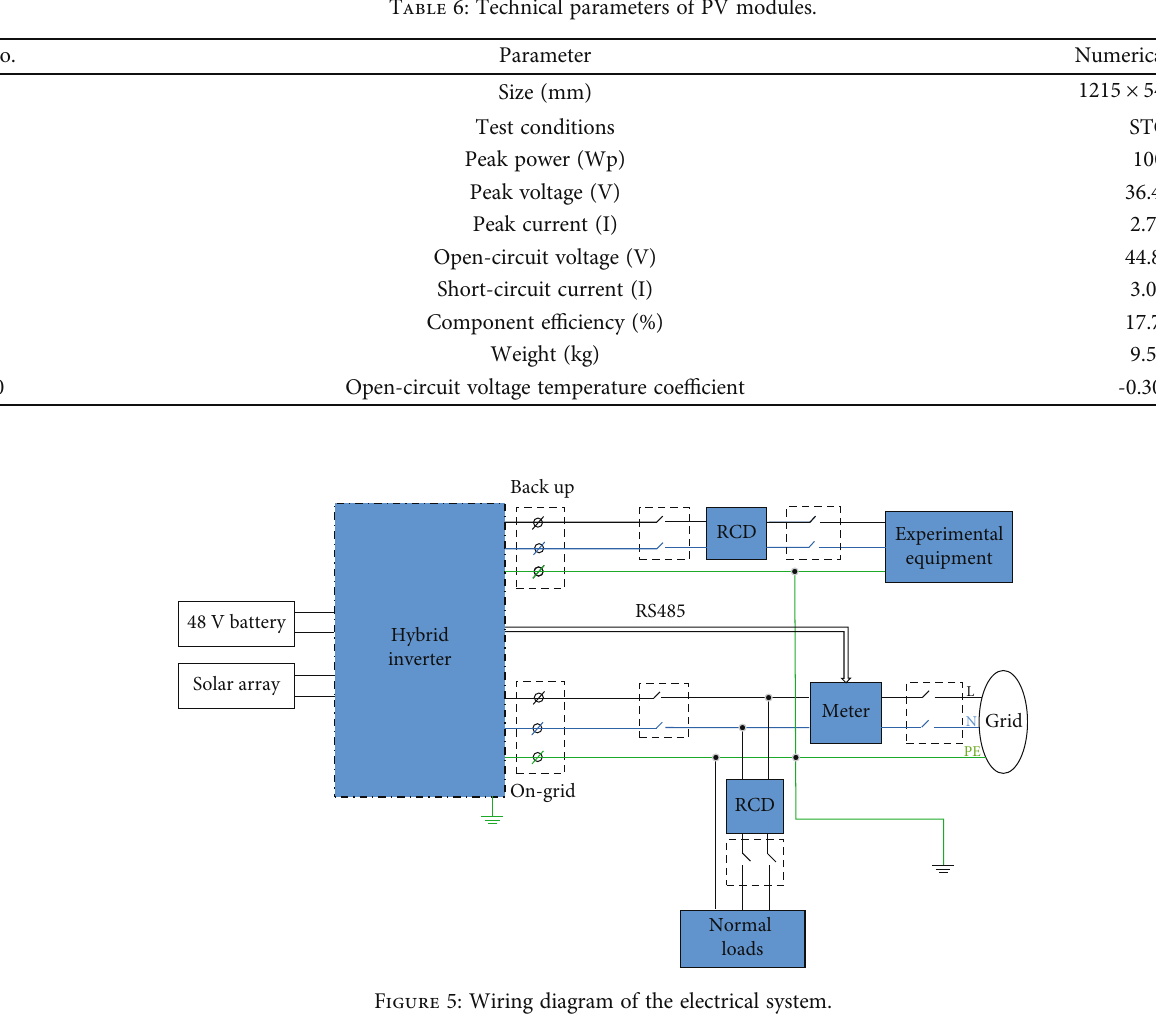
Table 6: Technical parameters of PV modules.